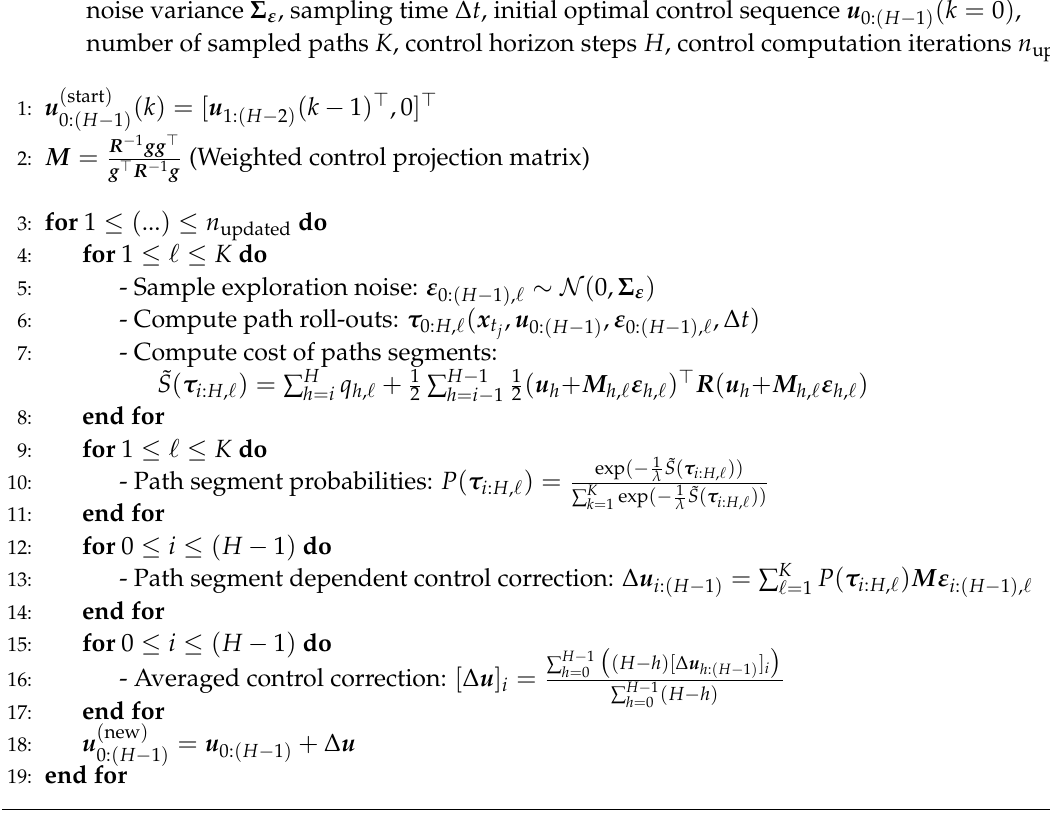
Algorithm 3 PI 2 for path